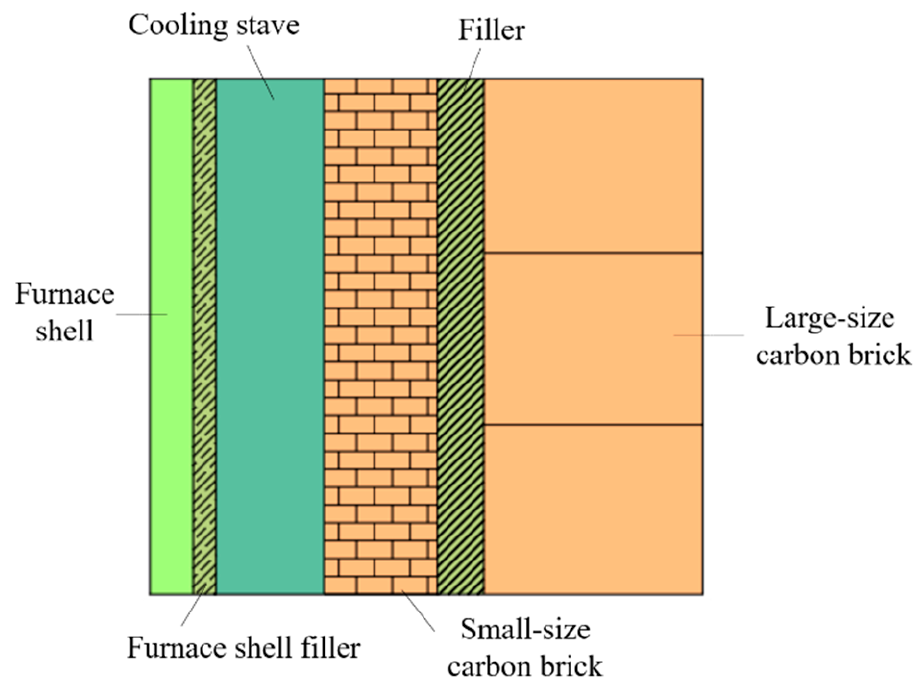
Figure 13. Schematic diagram of the hearth structure using composite carbon bricks.